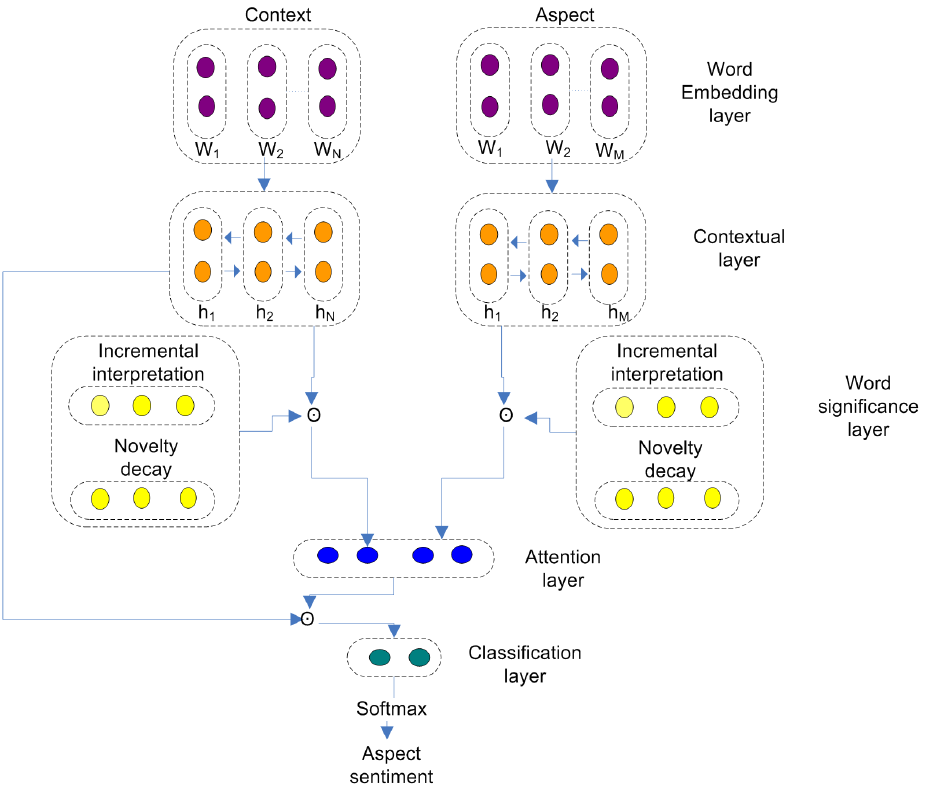
Figure 1. The architecture of the proposed ISAN